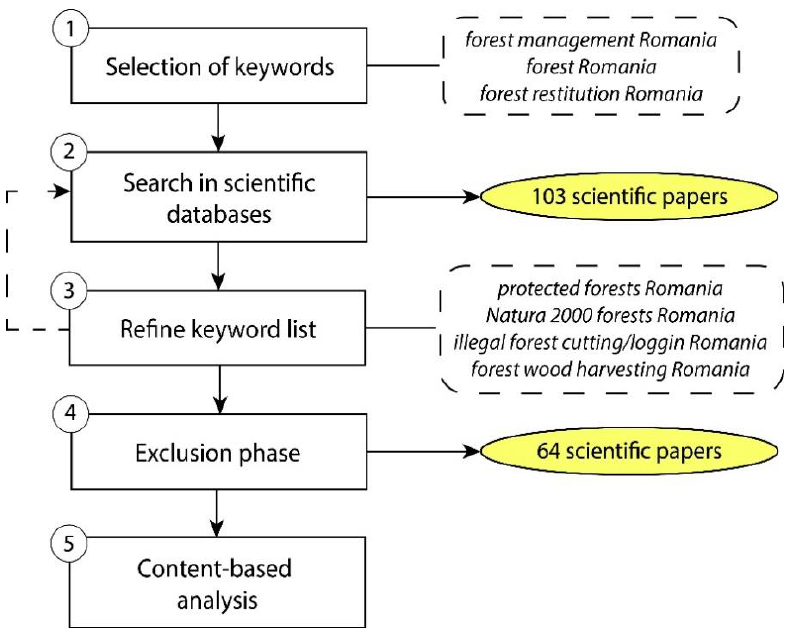
Figure 4. Literature review methodology using five steps.